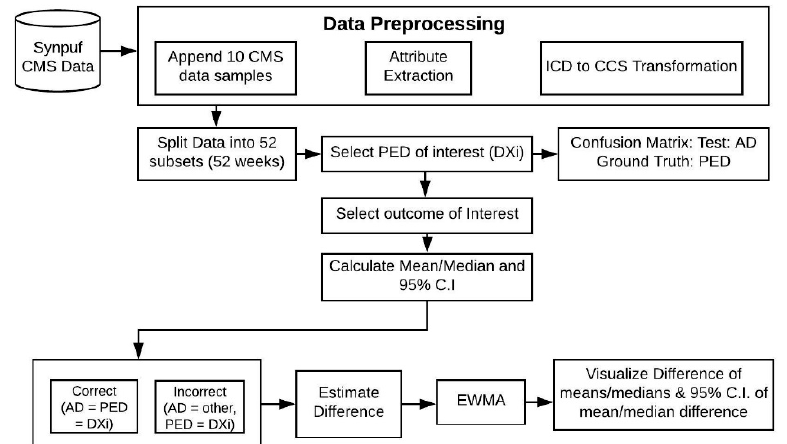
Figure 1. Overview of the methodological framework.